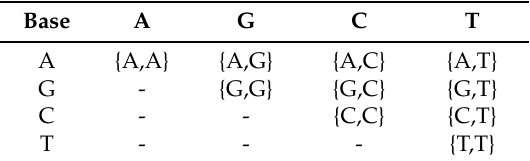
Table 1. The 2-combinations of multiset t8¨ A, 8¨ G, 8¨ C, 8¨ T u